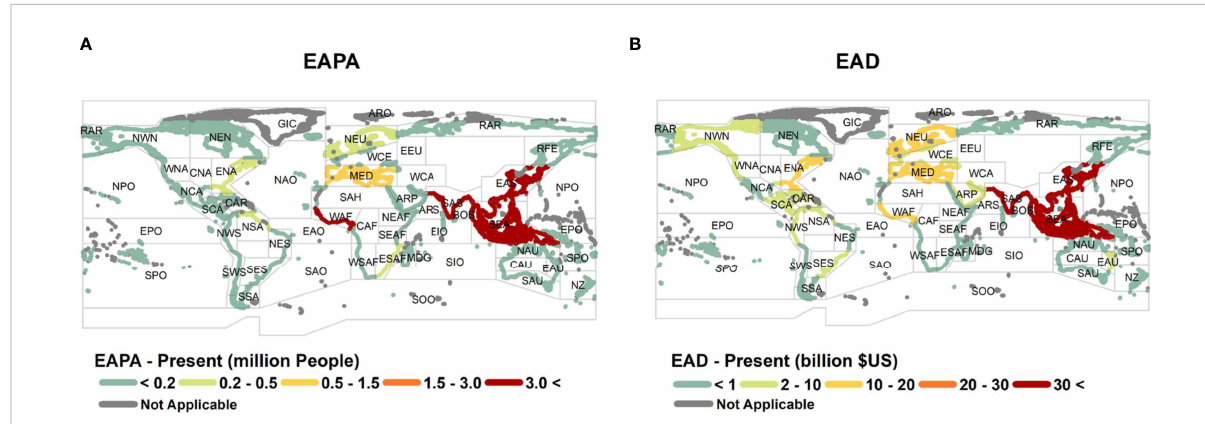
FIGURE 2 Present-day values (2015) of (A) Expected Annual People Affected ( EAPA ) and (B) Expected Annual Damage ( EAD ) in each of the 51 climate reference regions de fi ned by Iturbide et al. (Iturbide et al.,